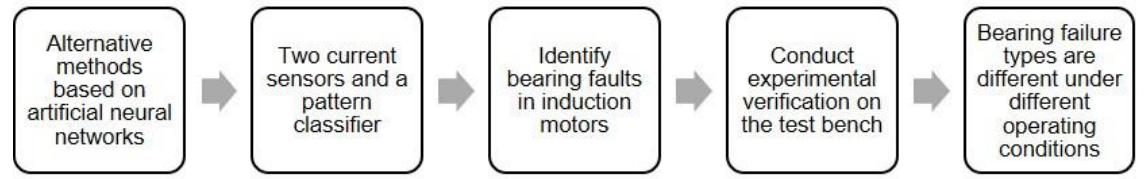
Figure 3. Diagram of a process where noise is eliminated by a driving algorithm before signal acquisition.